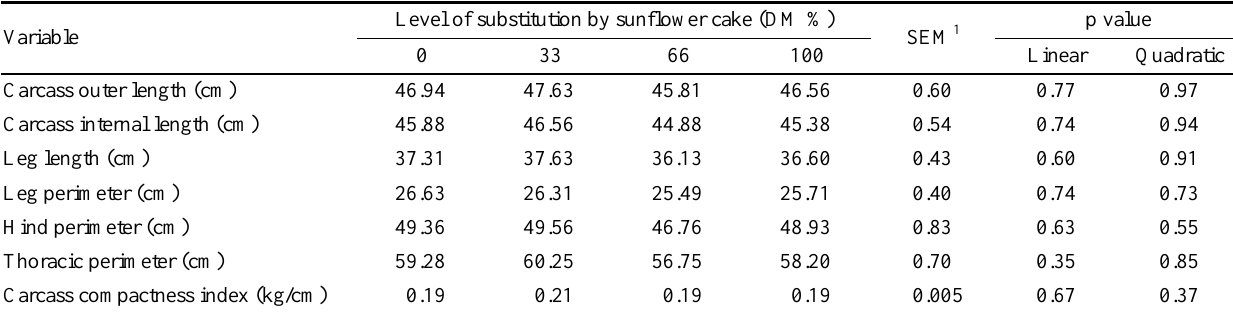
Table 4. Biometric measurements and carcass compactness index of 1/2 Boer kids fed diets containing sunflower cake